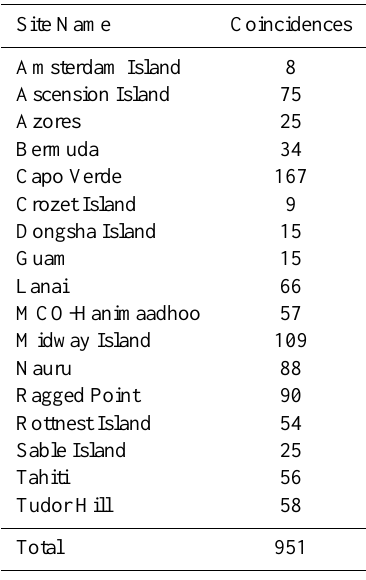
Table 2. Number of MISR-AERONET coincidences